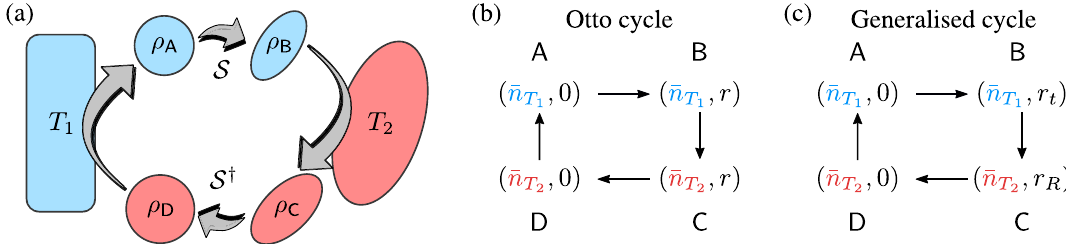
Figure 2. ( a ) Schematic diagram of the four-step protocol in which the bosonic mode is coupled with two different reservoirs. The unitaries S and S † represent the adiabatic squeezing and unsqueezing modulation of the bosonic mode. Diagrammatic representation of the ( b ) Otto and ( c ) generalised cycles. While in the former, the classicality varies during the system’s interaction with the hot reservoir, in the latter, it is kept